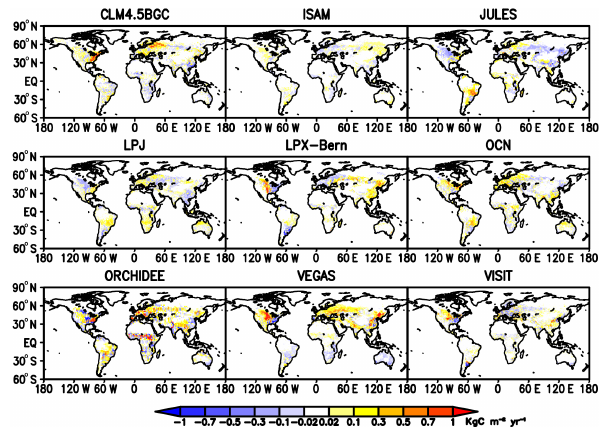
Figure 9. Contribution from land use/cover change on trends in the seasonal amplitude of global land–atmosphere carbon flux. For each spatial grid, the trend is computed as trends of the F i Methodology section for definition) in the S3 experiment (changing CO 2 , climate and land use/cover) subtracted by trends in S2 (chang- ing CO 2 and